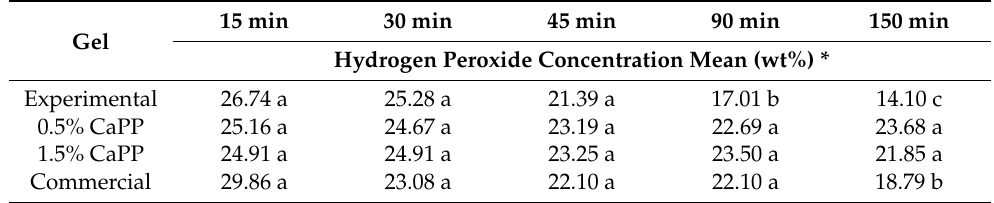
Table 1. Hydrogen peroxide concentration of the bleaching gels determined through the iodometric